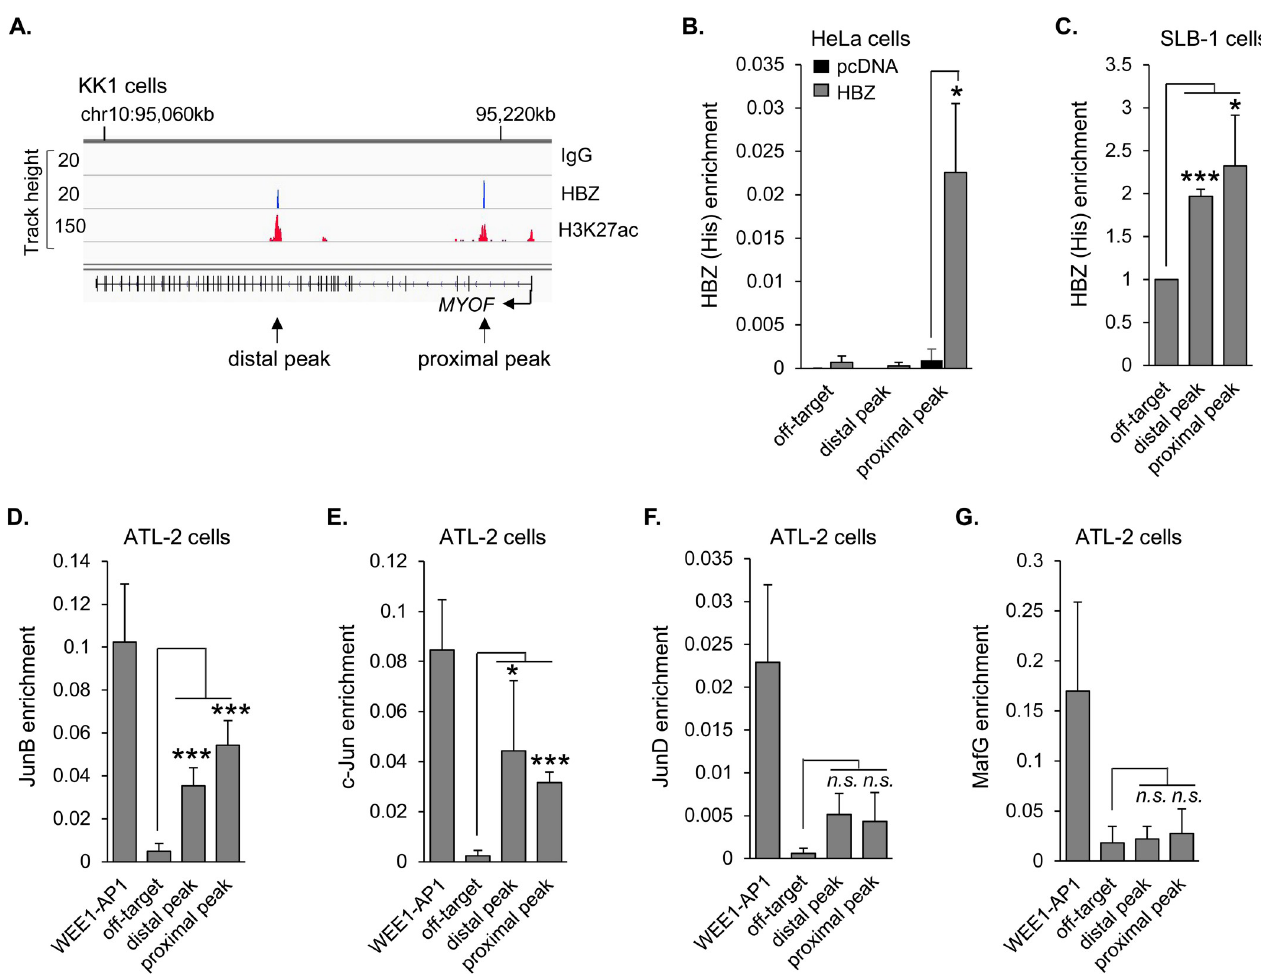
Fig 3. HBZ binds the MYOF gene in conjunction with c-Jun and JunB. (A) HBZ binds to two sites within the MYOF gene in the ATL cell line, KK1. Peaks of enrichment for HBZ, the epigenetic mark, H3K27ac, and control (IgG) at the MYOF locus in KK1 cells are shown in the IGV Browser. Genomic coordinates are based on the NCBI36/hg18 assembly. Data were obtained from published ChIP-Seq data sets (GEO accession number GSE94732 [56]). (B) HBZ binds to the proximal peak in HeLa cells. The graph shows average values from three independent ChIP assays using empty vector (pcDNA) and HBZ (6x His C- terminal tag)-expressing HeLa cells. Shown are levels of HBZ-enrichment at the off-target site (1,796 bp from the end of the gene) and at the distal and proximal peaks with respect to the TSS; � p < 0.05. (C) HBZ binds the distal and proximal peaks in SLB-1 cells. The graph shows fold enrichment relative to that for the off-target site (set to 1) averaged from three independent ChIP assays using SLB-1 cells transduced to express HBZ with a C-terminal 6x His tag; � p < 0.05, ��� p < 0.001. (D) and (E) JunB and c-Jun are enriched at the distal and proximal peaks in ATL-2 cells. (F) and (G) JunD and MafG are not enriched at the HBZ-binding peaks. Graphs show average values from five (D and E) to three (F and G) independent ChIP assays using ATL-2 cells; � p < 0.05, ��� p < 0.001, n . s : non-significant. Factor-enrichment was analyzed at the off-target site, the distal and proximal MYOF peaks, and at the AP1 site in the WEE1 promoter (WEE1-AP1).